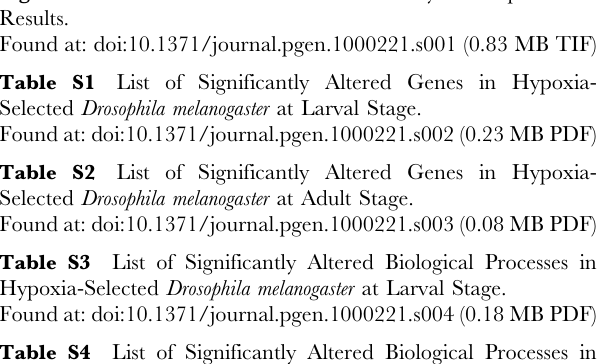
Table S5 Primers for qRT-PCR and ChIP-PCR Assays. Table S6 Summary of Genomic Locations of hairy Transcription Repressor Binding Elements in the cis -Regulatory Regions of Genes Encoding TCA Cycle Enzymes. Table S7 Comparison of the TPI Genomic Locus between NF and AF with Multiple Sequence